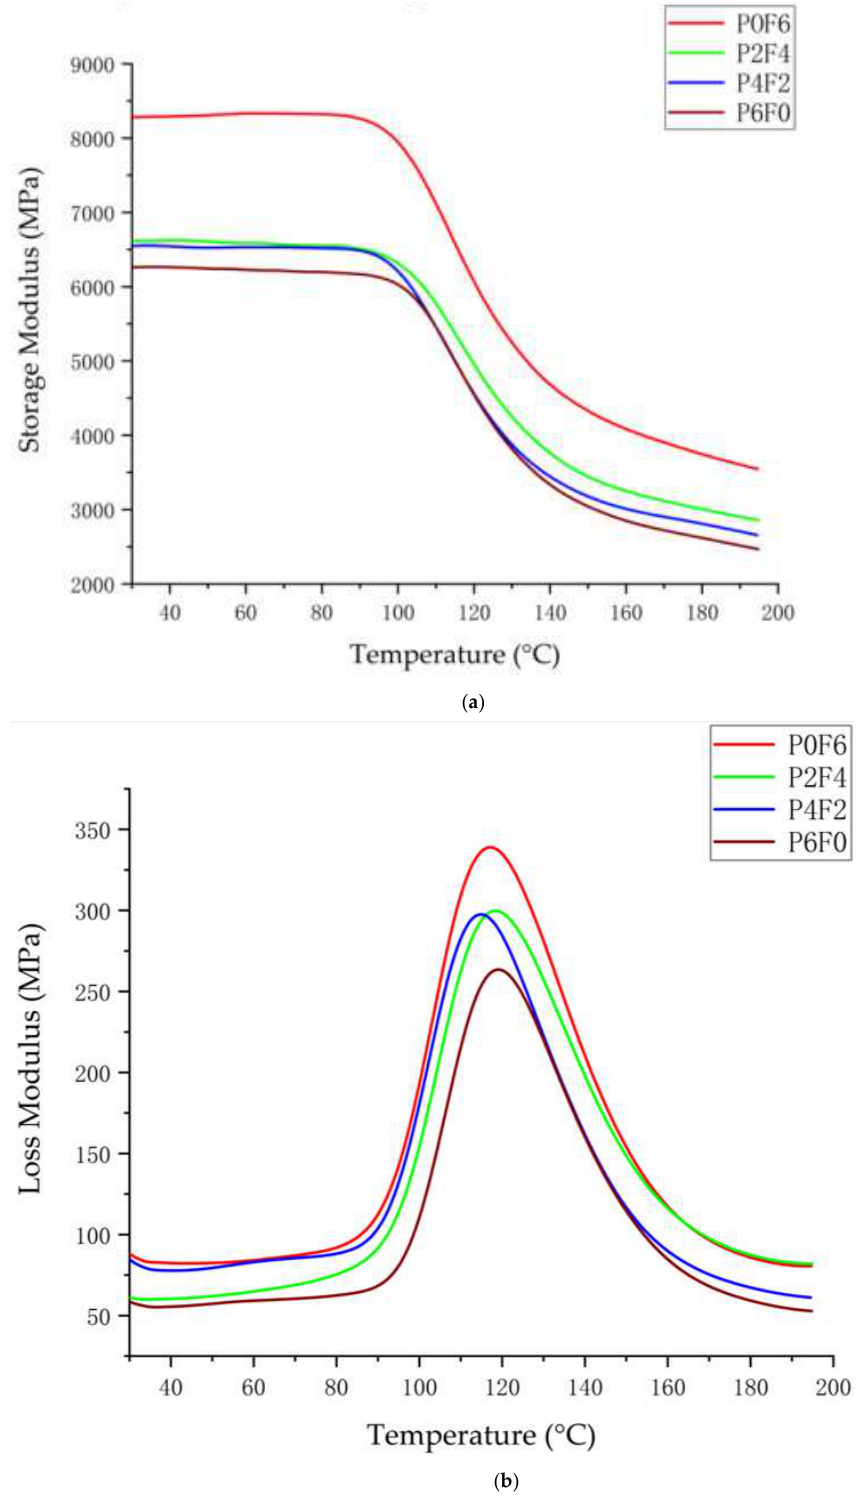
Figure 7. Effect of different polyphenylene sulphide forms on the dynamic mechanical properties of composites: (a) storage modulus; (b) loss modulus.